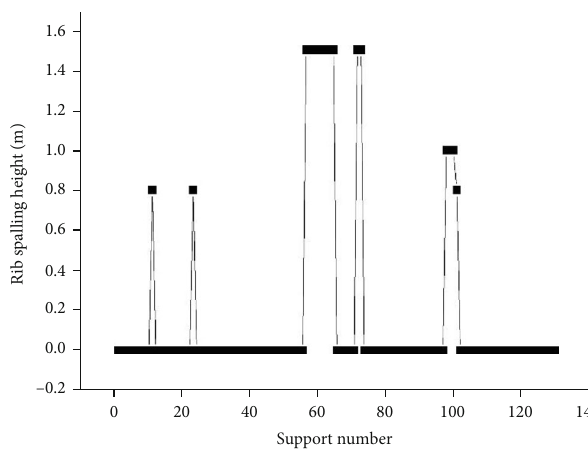
Figure 12: Rib sloughage